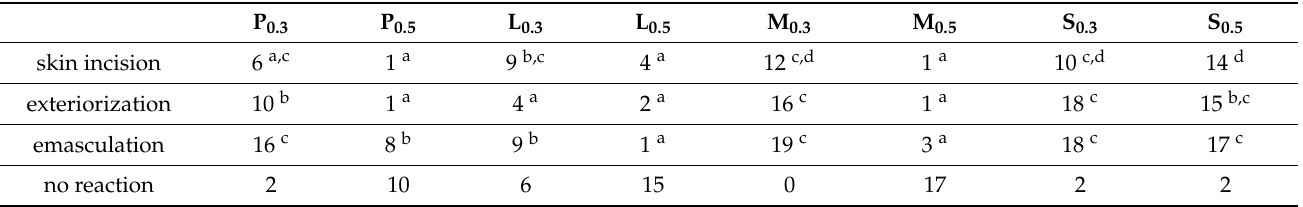
a, b, c, d : Different letters (a, b, c, d) show significant differences between the experimental groups ( p < 0.05).